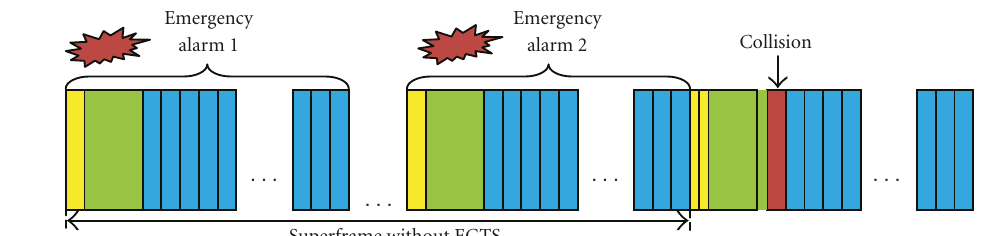
Figure 7: Multiple emergency alarms occur in a same superframe group.